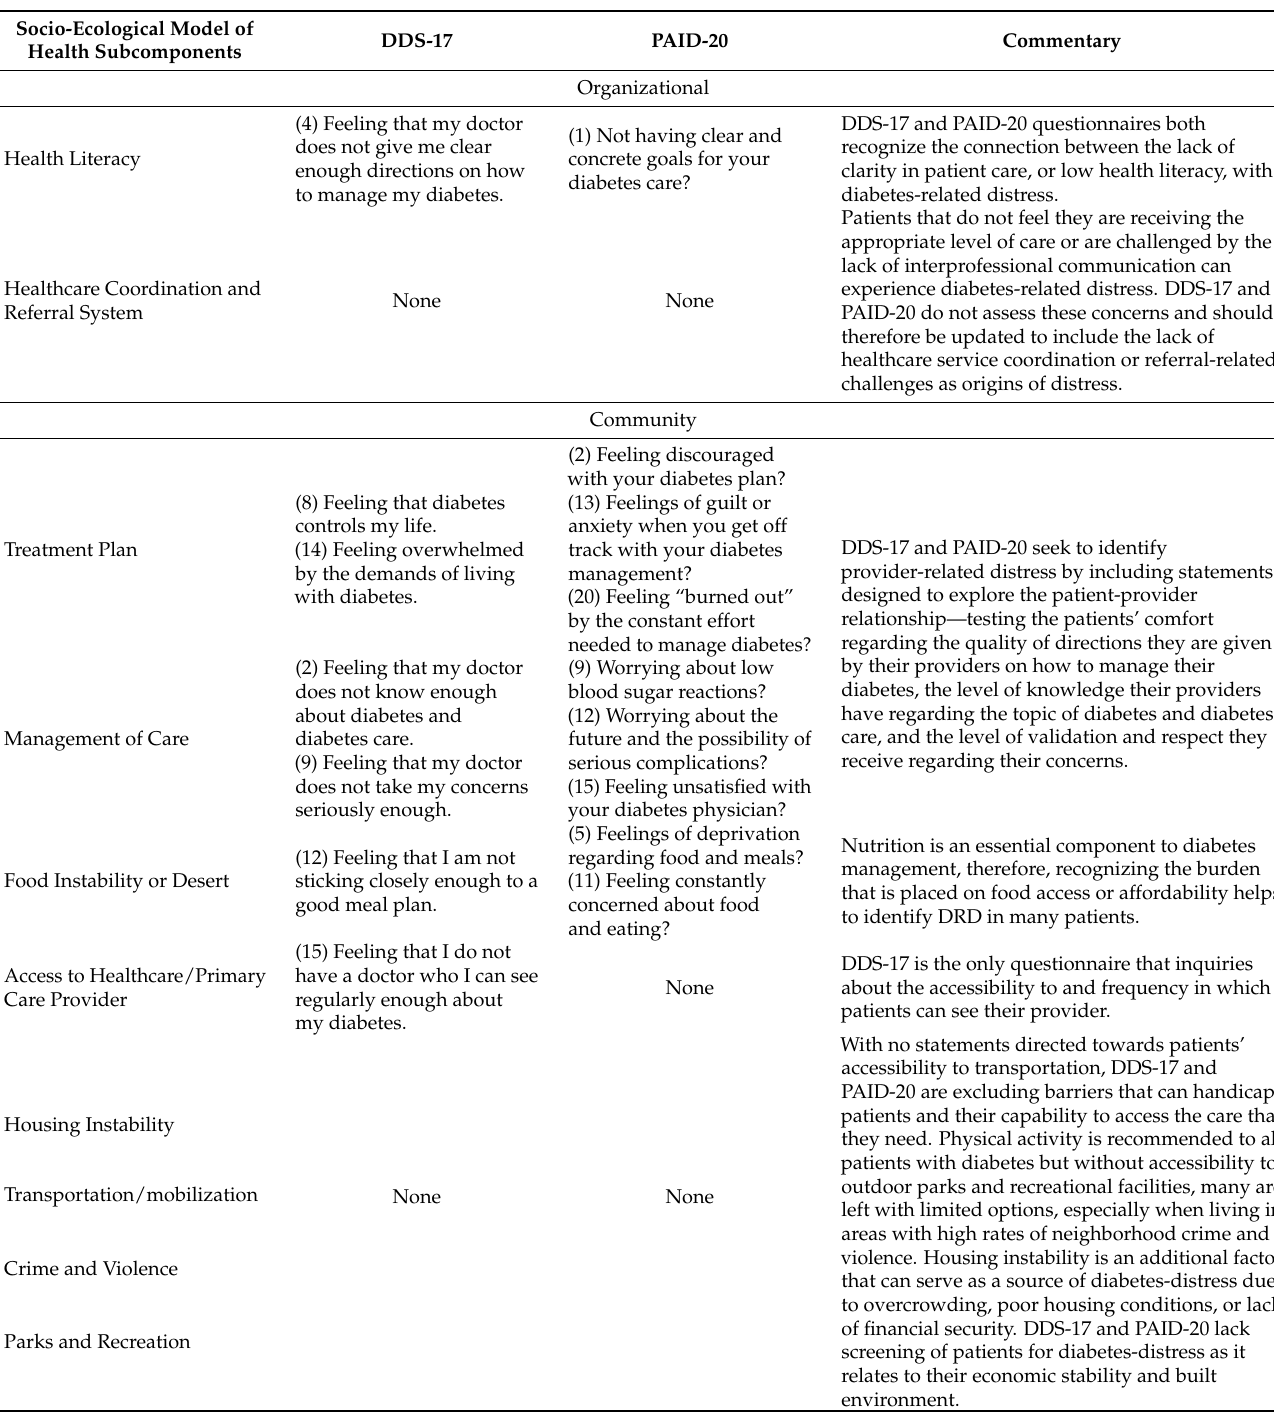
Table 1. Subcomponents of the socioecological model of health that are present or absent in the DDS-17 and PAID-20